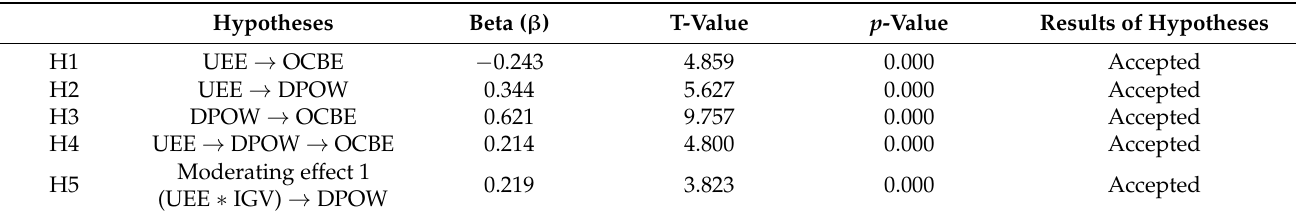
Figure 2. The tested structural and measurement model. UEE → underdog environmental expecta- tions; OCBE → organizational citizenship behavior for the environment; DPOW → the desire to prove others wrong; IGV → individual green values. Table 5. The structural model’s